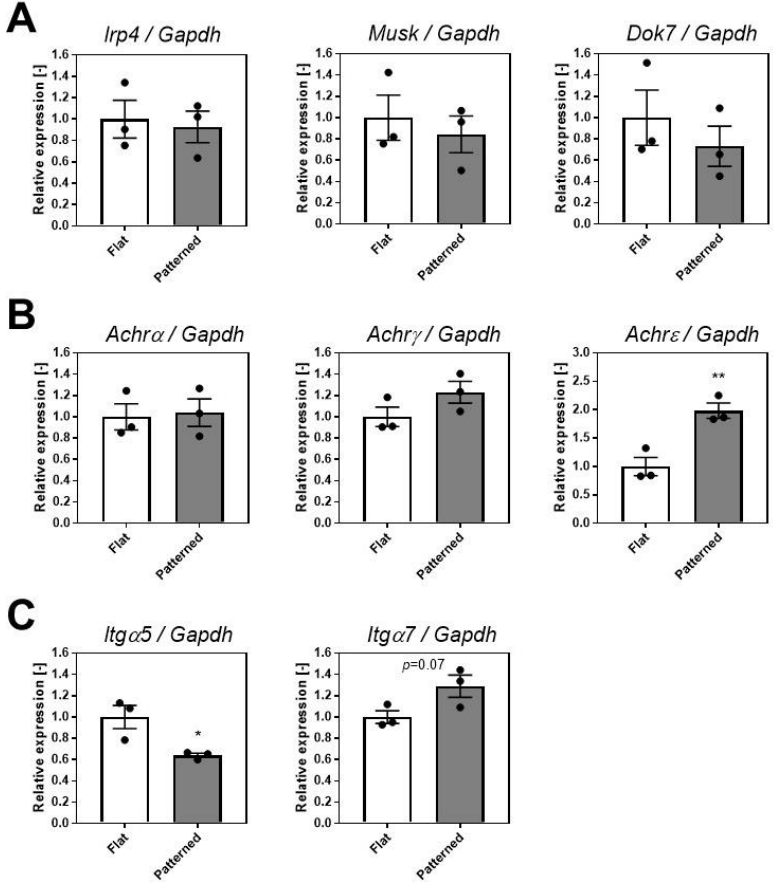
Figure 2. Gene expression analysis of C2C12 cells cultured on the patterned surface. ( A ) Lrp4 , Musk , and Dok7 . ( B ) Achrα , Achrγ , and Achrε . ( C ) Itgα5 and Itgα7 . Data are expressed relative to Gapdh . Data points represent mean ± SD ( n = 3). * p < 0.05 versus flat. ** p < 0.01 versus flat.